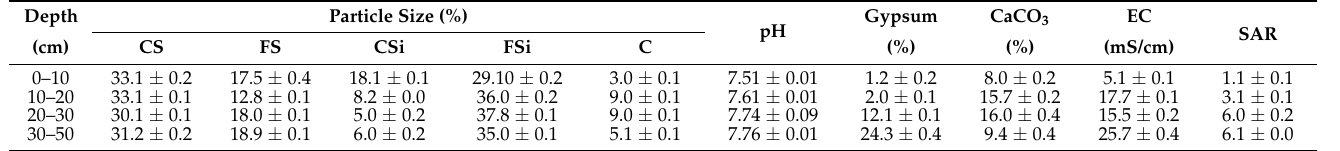
Table 1. Soil properties in 2012 (Mean ± Standard Error; n = 3).